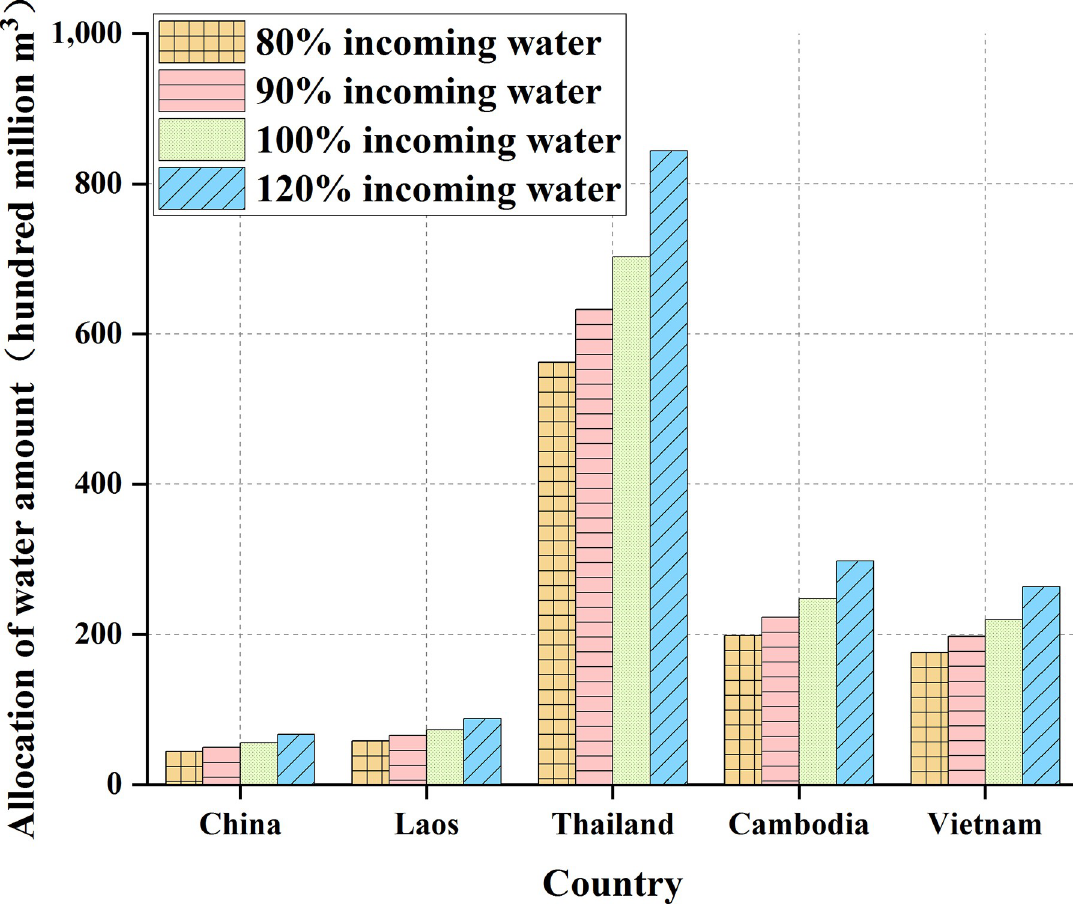
Fig 9. Comparison of water resources allocation in five